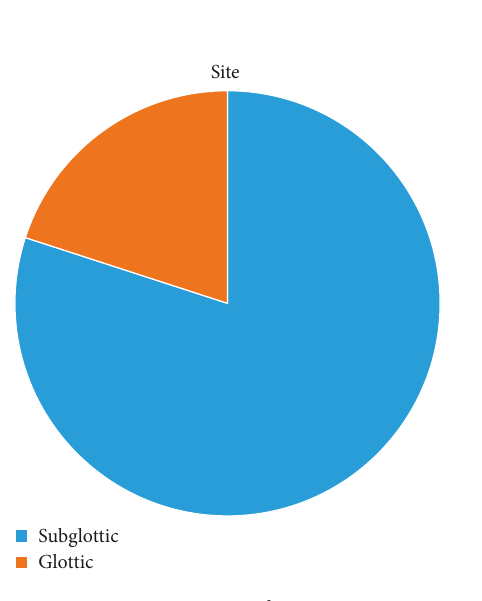
Figure 11: Comorbidities in males and females.